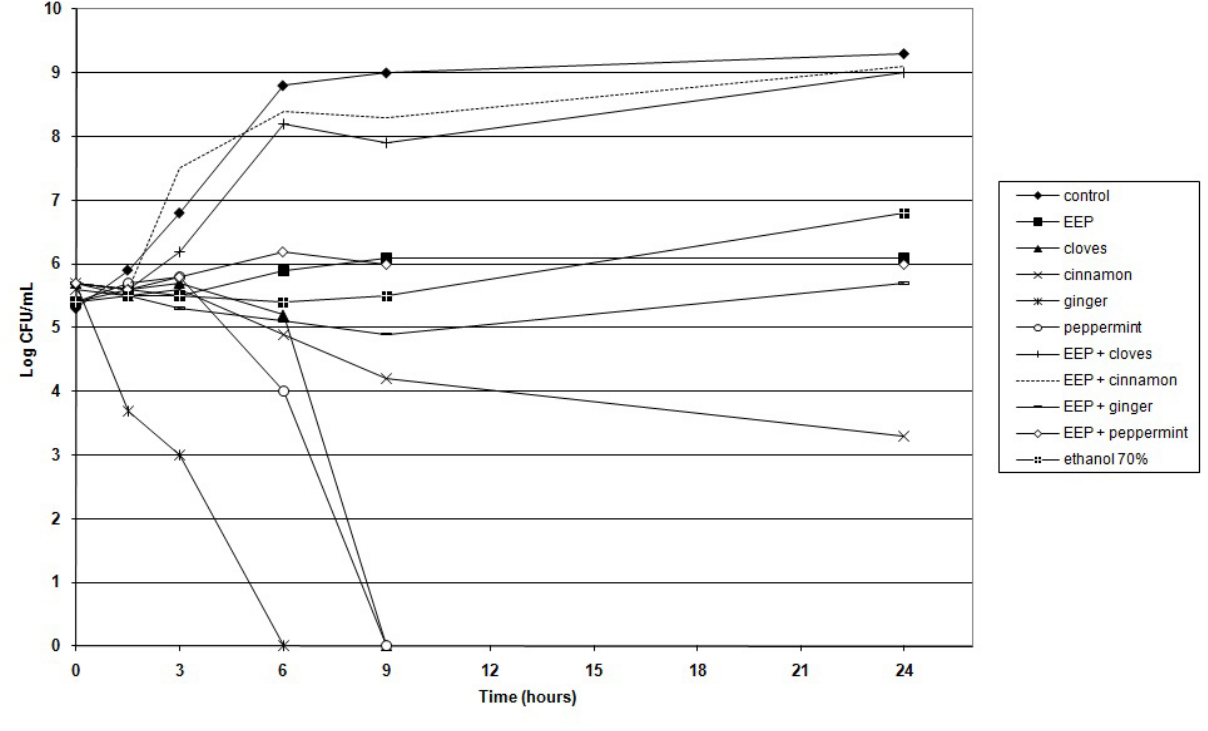
values of the products alone and in 90% values for EEP with essential oils against S. aureus 90%